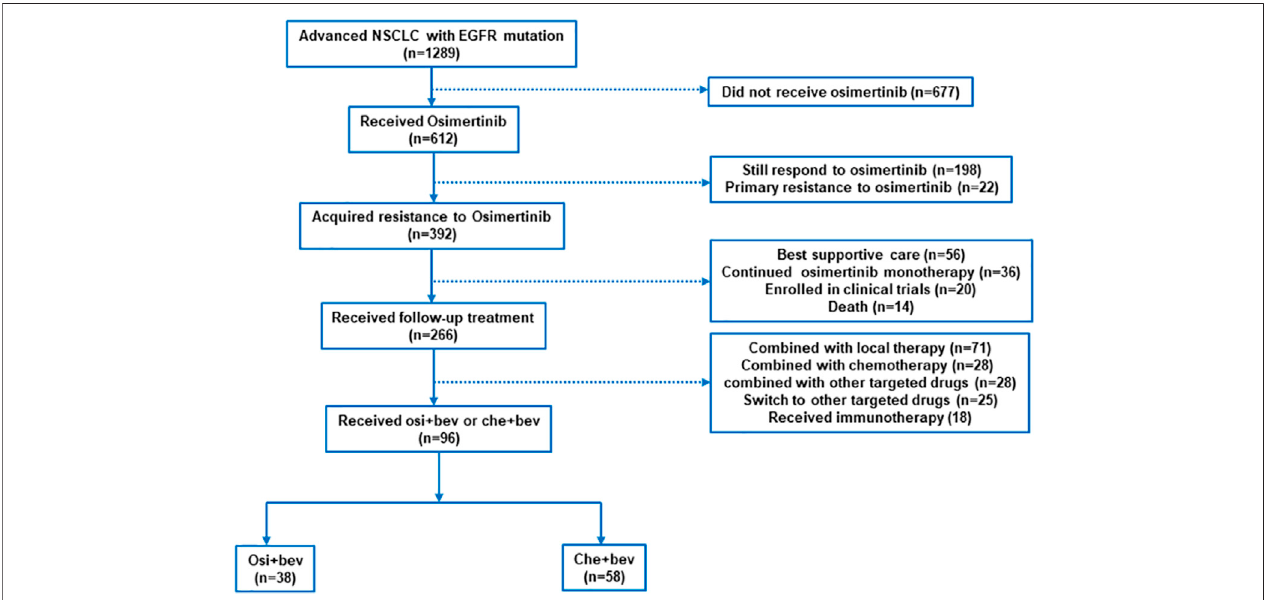
FIGURE 1 | Study cohort